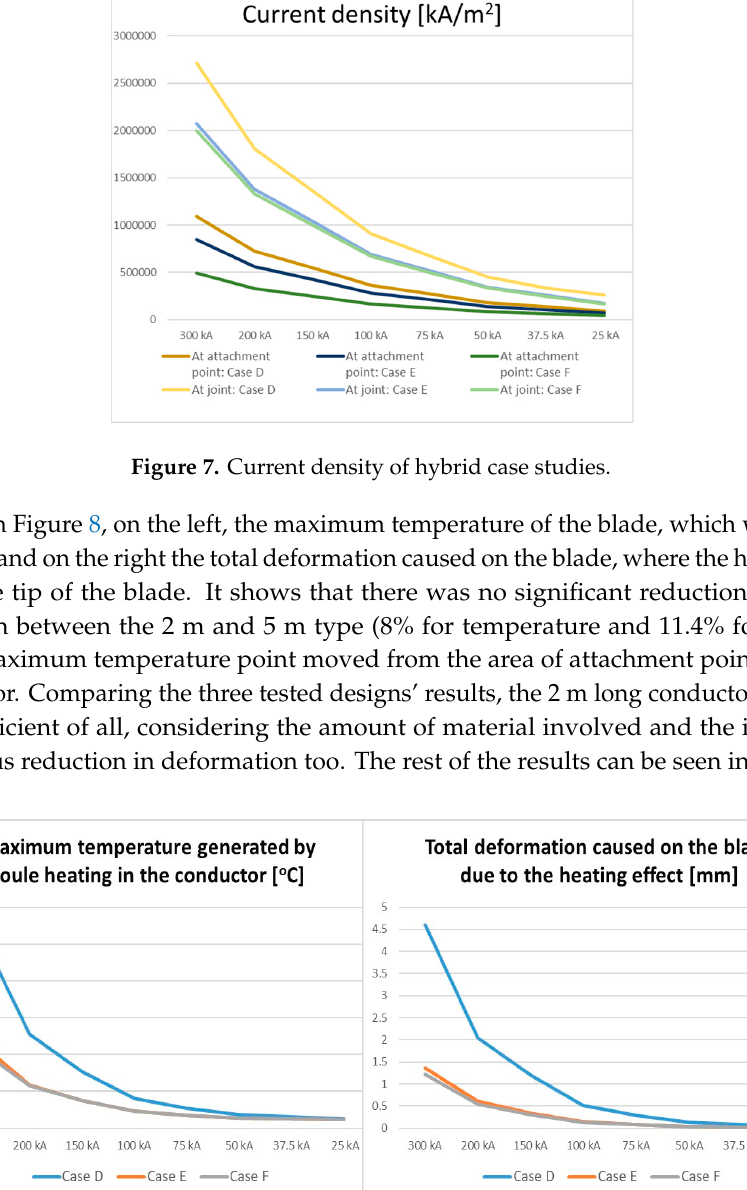
Figure 6. Graphical simulation results, hybrid design (case study E); a) current density in the conductor, b) temperature generated by current, c) deformation caused by temperature